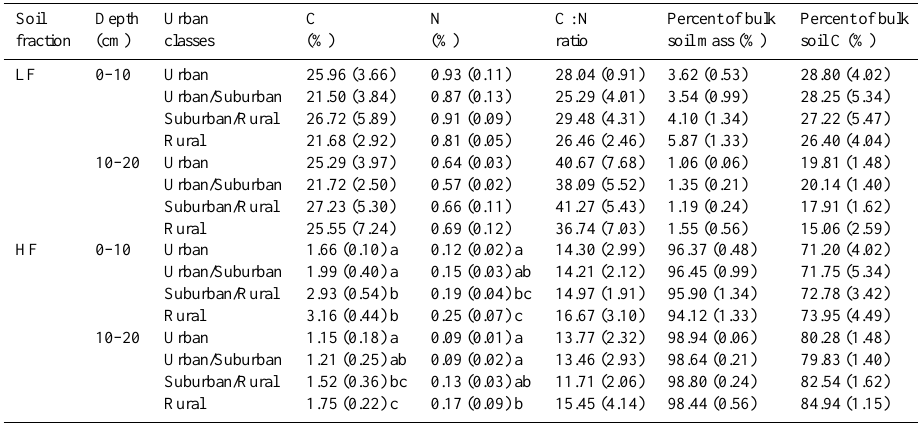
Table 2. Characteristics of two soil fractions.